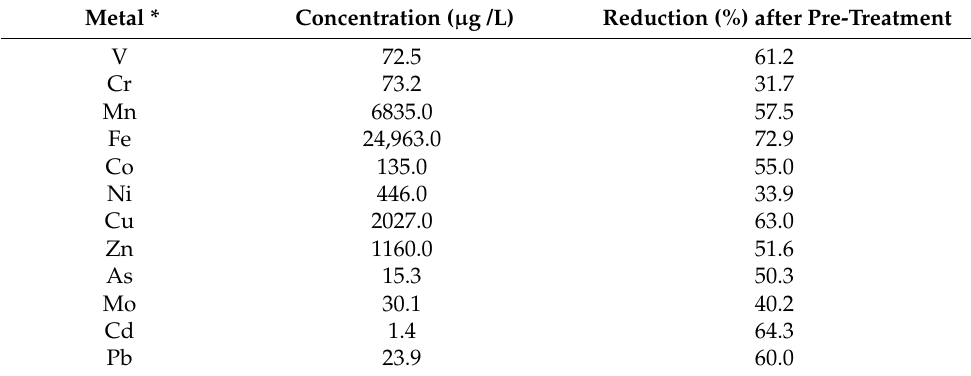
Table 4. Metal reduction in molasses after